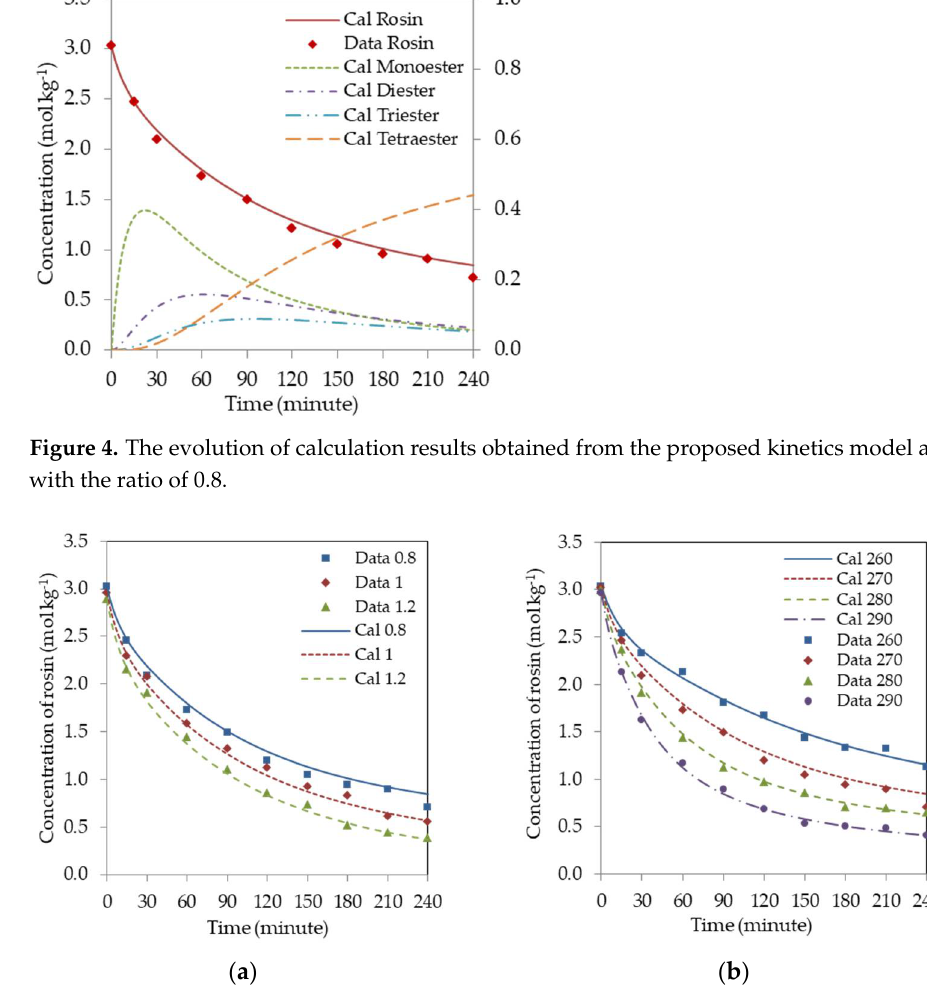
MAPE is another accuracy measurement. MAPE of the acid number and the ester num-